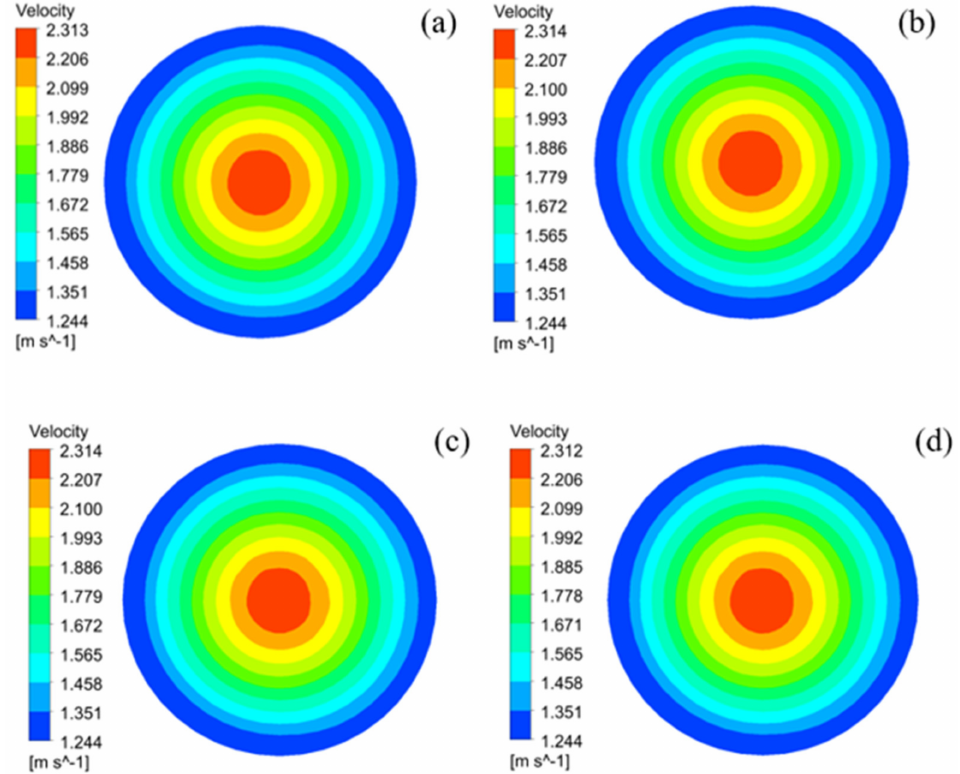
Figure 8. Distribution of flow velocity on the outlet surface of PCMT with different porosity: ( a ) 30%, ( b ) 35%, ( c ) 40% and ( d )